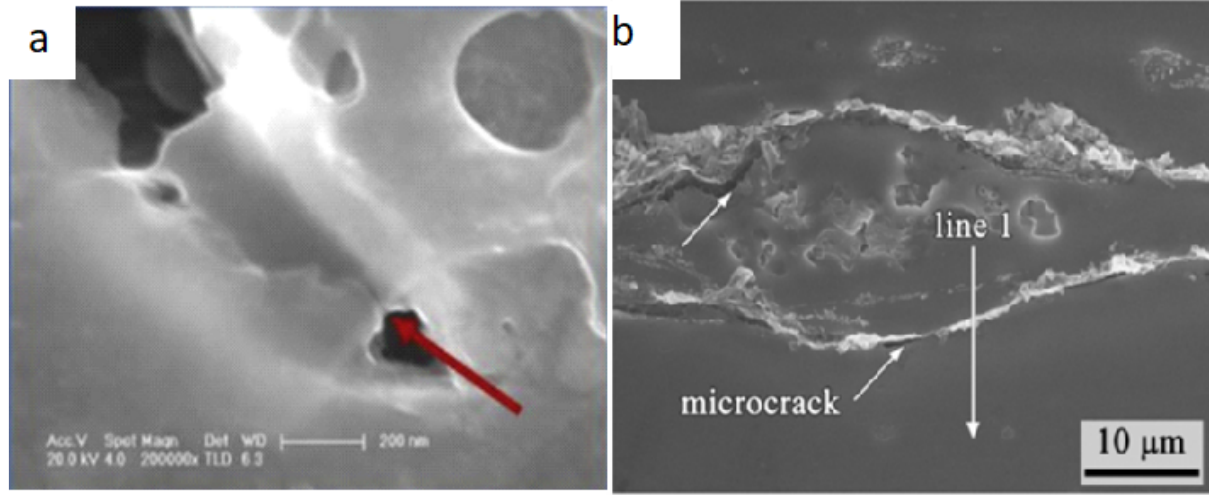
Figure 21: (a) TEM image showing the arrest of a microcrack by a graphene sheet. (b) SEM image showing microcracks in the composite rods along the rolling direction. Reproduced from References [139] and [53],